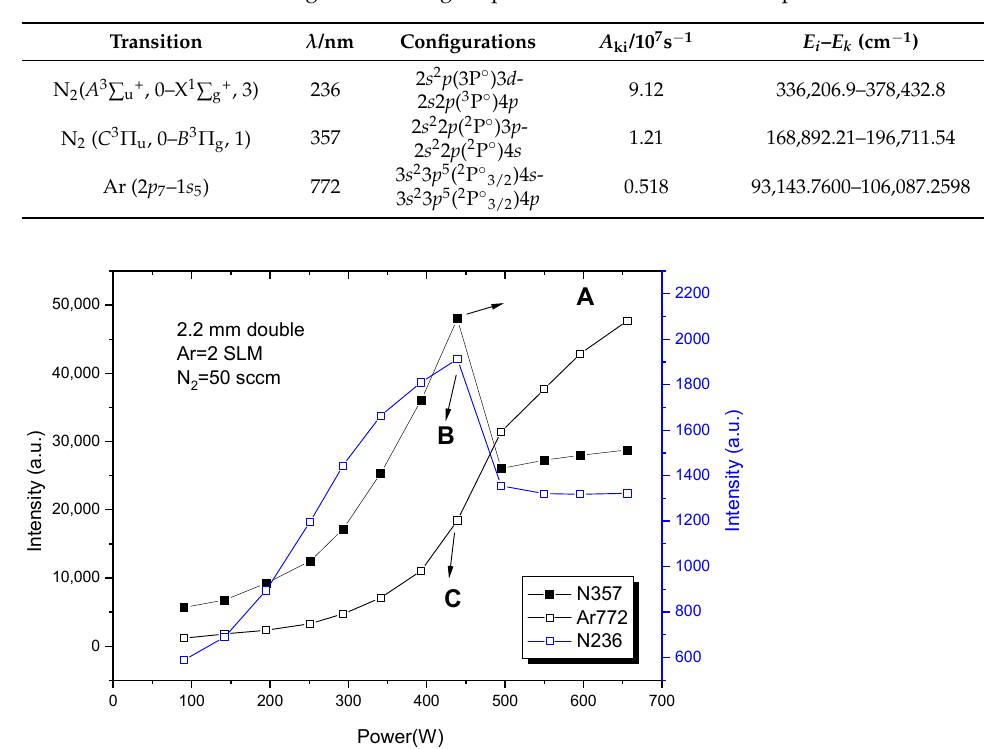
Figure 8. Variation of line intensity with power in discharge using argon-doped nitrogen. Points A, B and C in the three curves are the locations where the discharge mode changed from glow discharge to filamentous discharge.